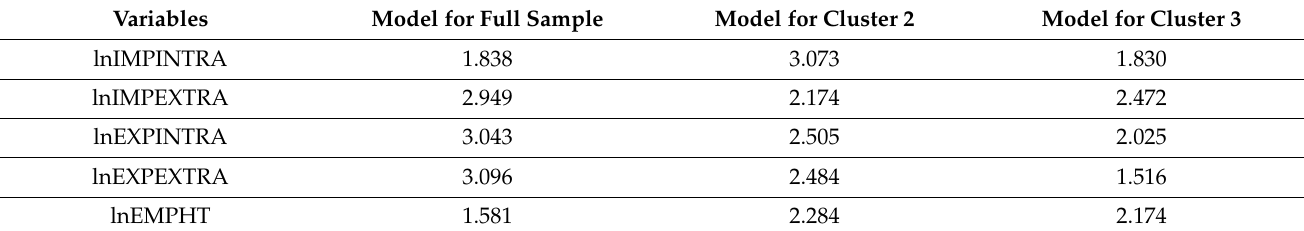
Table 4. VIFs results.